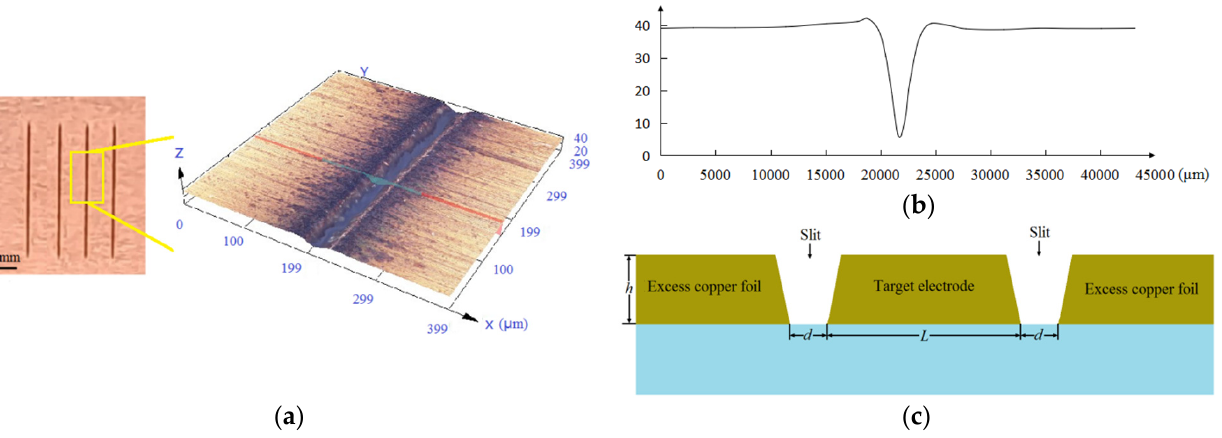
Figure 6. The shape of the incision. ( a ) Slit topography; ( b ) slit profile; ( c ) slit profile model diagram.